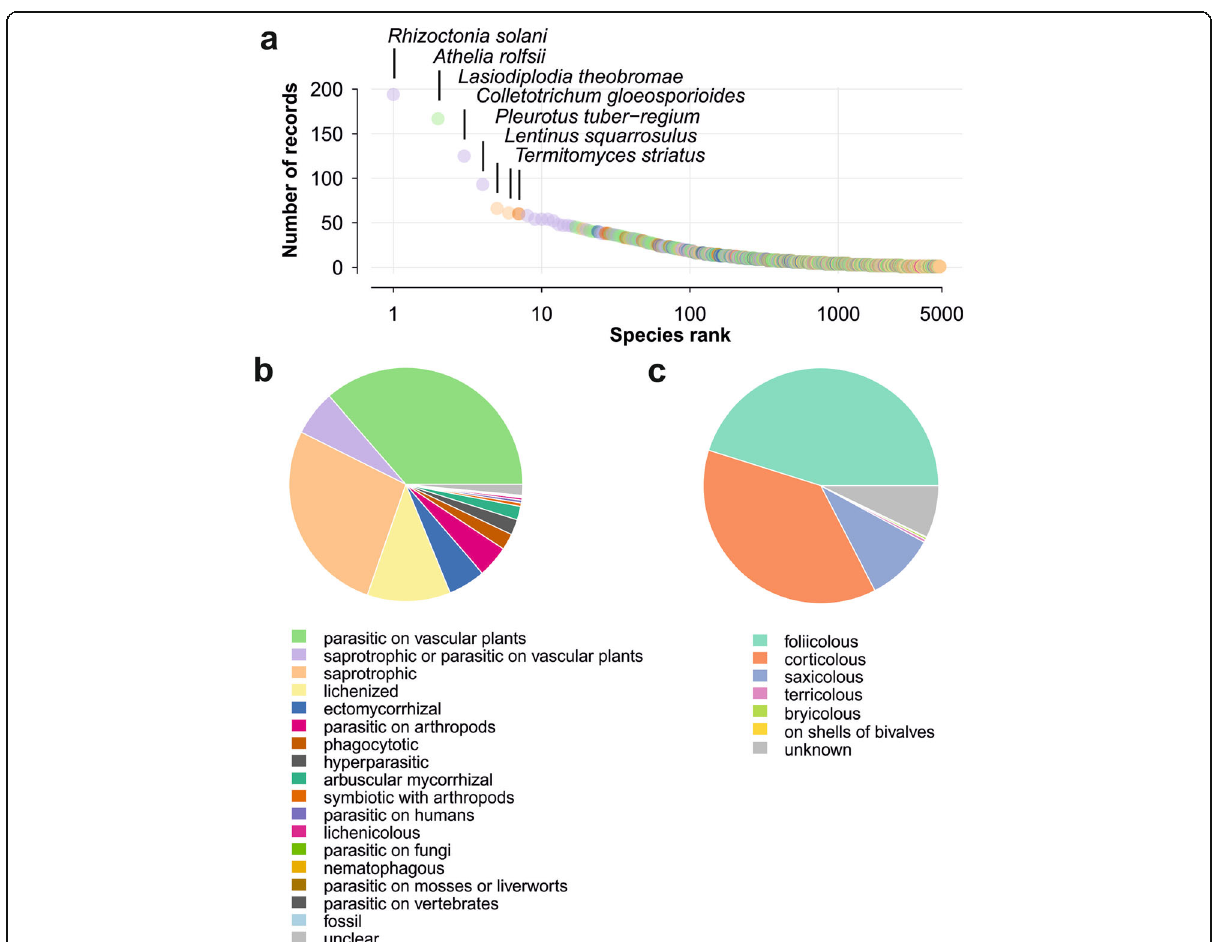
Fig. 4 Analyses of records, life forms, and substrata of species of fungi and fungus-like organisms reported for West Africa. a Rank abundance curve showing the numbers of records per species. Species ranks are presented in a logarithmic scale. Names of the most frequently reported species are indicated. For the interpretation of colors of dots see Fig. 4b. b Relative frequency of life forms of fungal species recorded for West Africa. c Relative numbers of species of lichens recorded for different substrata in West Africa. Foliicolous = lichen thallus growing on leaves, corticolous = on bark, saxicolous = on stones or rocks, terricolous = on soil, bryicolous = on bryophytes. If several substrata are cited for the same species of lichen, this species is counted for each of the